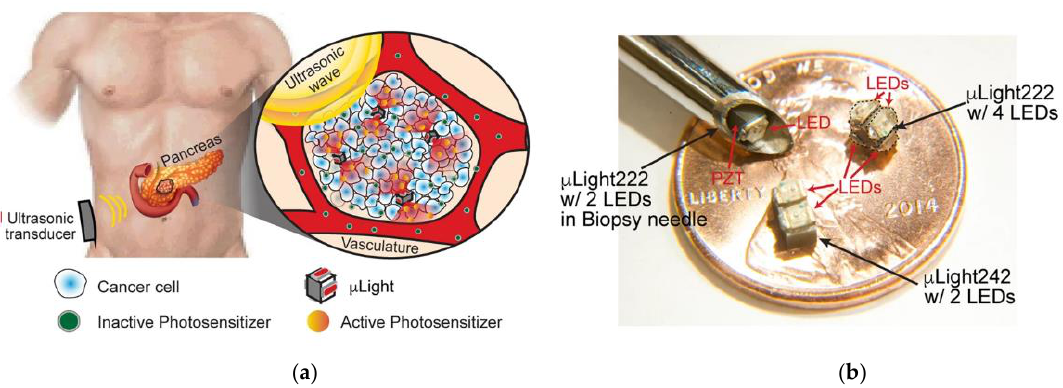
Figure 11. ( a ) Illustration of implantable µLight in a deep-seated tumour: ultrasonic waves applied from an external transducer travel through the tissue to trigger light generation by the μLight, thus activating a pre-delivered PS, which in turn generates ROS to kill cancer cells. ( b ) Photographs of fabricated prototypes. Reproduced with permission from A. Kim et al., Scientific Reports; published by Springer Nature, 2019 [242].